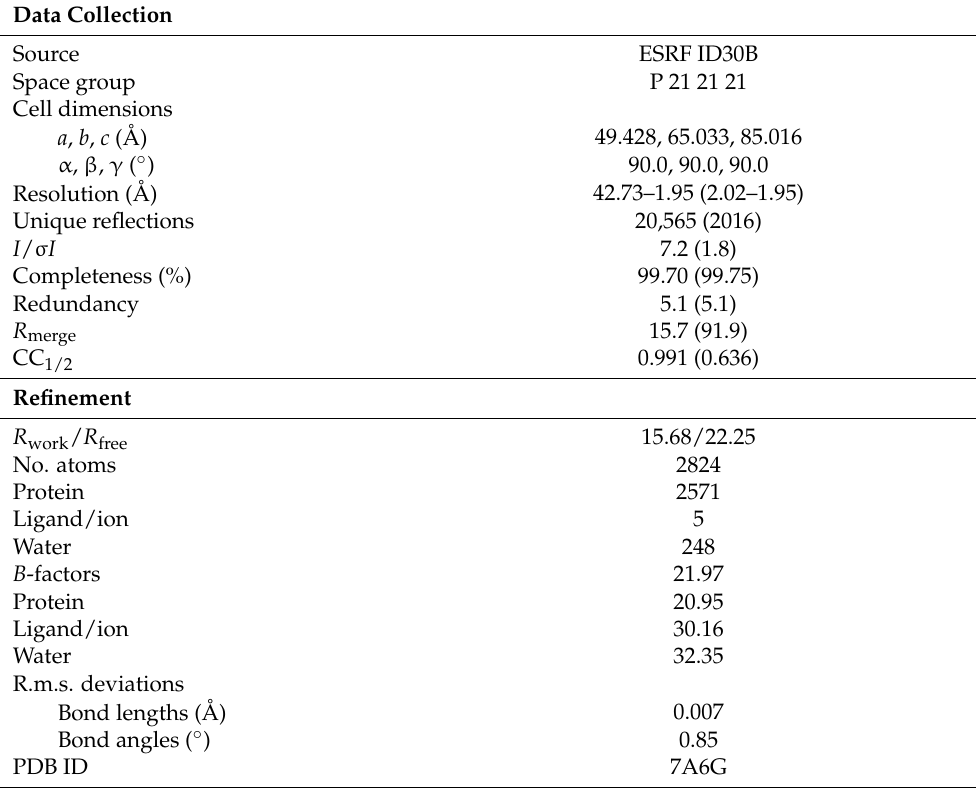
Table 1. Data collection and refinement statistics. (Statistics for the highest-resolution shell are shown in